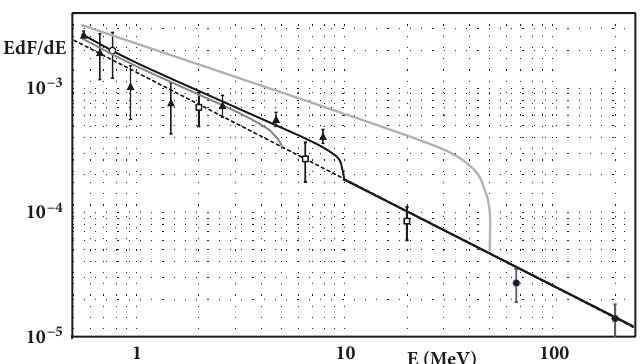
Figure 7: Spectrum, i.e., 𝐸×(𝑑𝐹/𝑑𝐸)(𝑐𝑚 −2 𝑠 −1 ) versus energy for 𝛾− rays from the inner galaxy for 𝐸 > 511 keV, as measured by 4 instruments: SPI (open circle), COMPTEL (open squares), EGRET (filled circles), and OSSE (filled triangles), as it appeared in [18]. All but the 7 OSSE points extracted from [21] are from Prantzos et al. [22], as are the 3 predicted enhancement curves above the straight line for positrons injected into a neutral medium at initial energies 𝐸 0 = 5, 10, 50 MeV displayed as the lower grey curve, the black curve, and the upper grey curve, respectively. The sloped straight line (also from [22] is a power law fit to the spectrum at high and low energies.